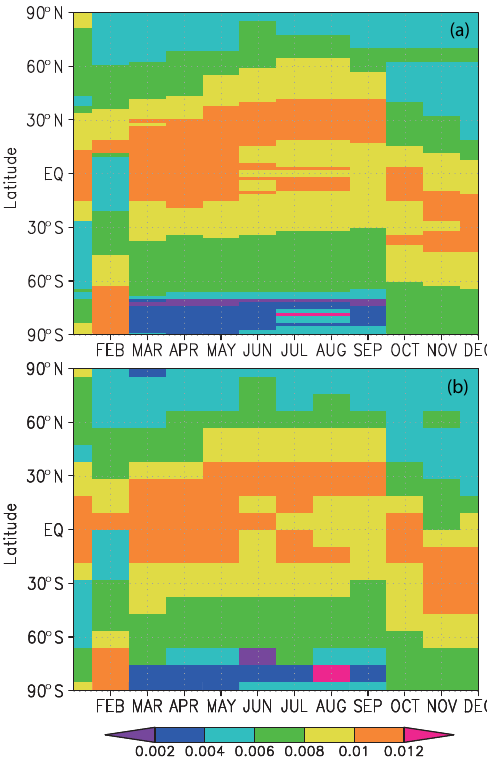
Figure 10. Latitude–time plots for instantaneous radiative forcing (Wm − 2 ) by SF 6 as a function of latitude and month at (a) high- latitude resolution (1.5 ◦ spacing) and (b) low-latitude resolution (9 ◦